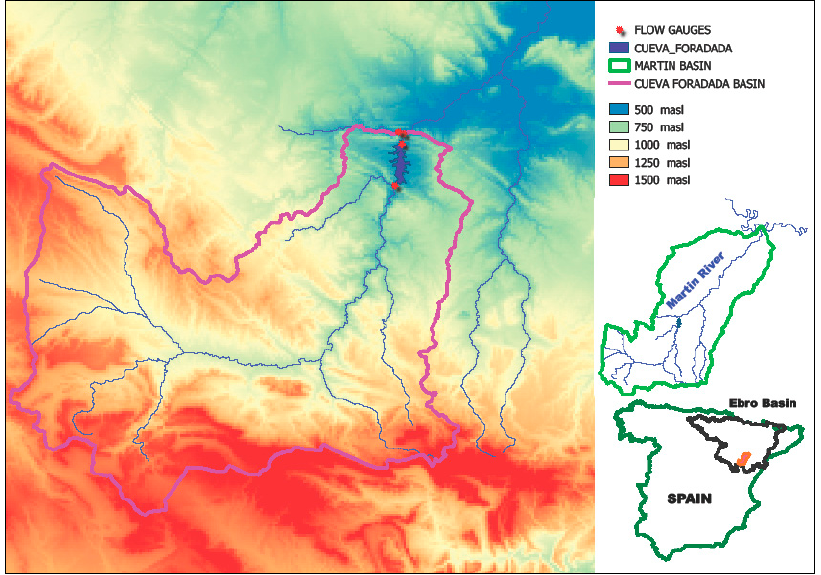
Figure 1. Location of the Cueva Foradada basin.